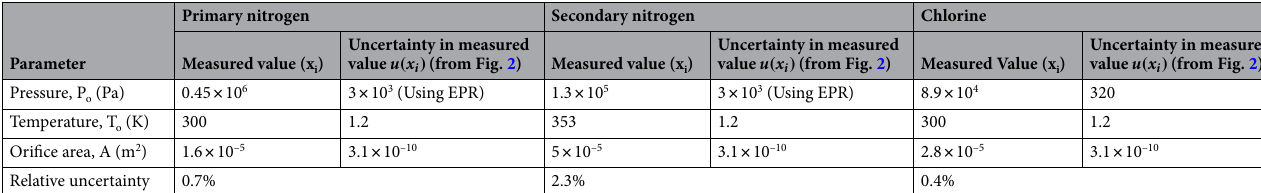
Table 4. Relative uncertainty in Primary N 2 , Secondary N 2 and chlorine